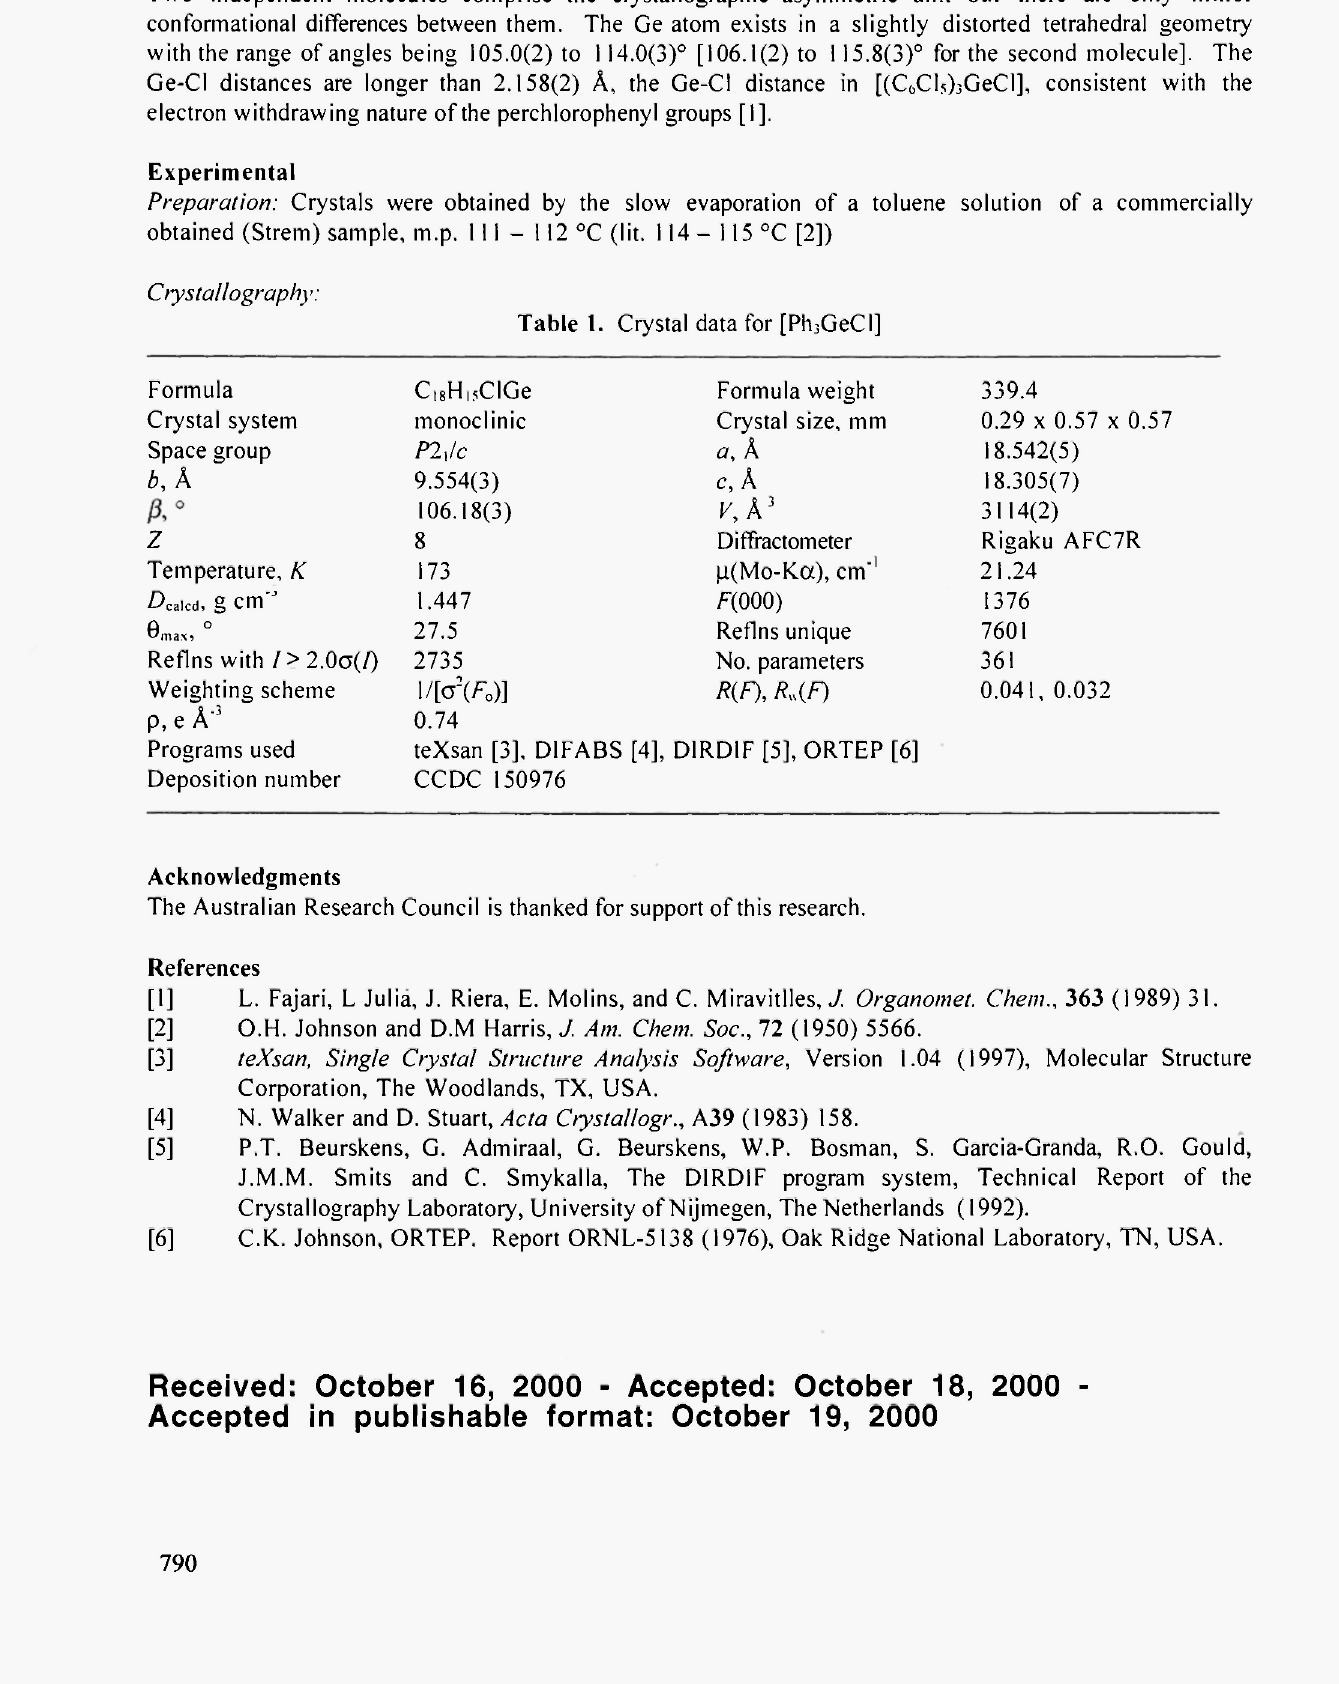
Table 1. Crystal data for [Ph 3